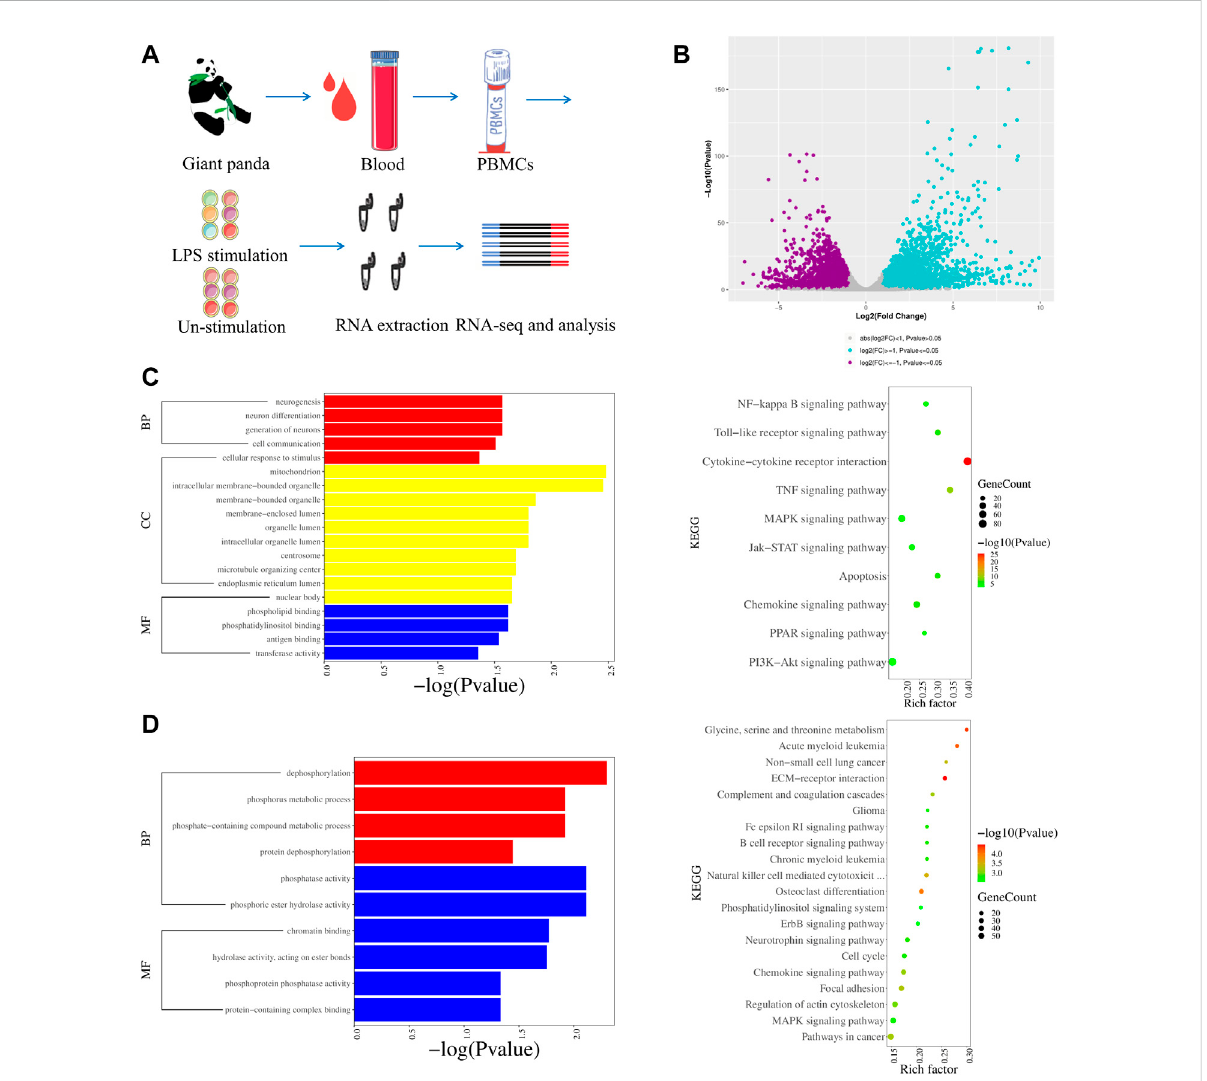
FIGURE 2 Transcriptomic pro fi les of LPS-stimulated and LPS-unstimulated PBMCs from giant pandas by RNA-seq. (A) Flow diagram of the experimental design. (B) VolcanoplotshowstheDEGsbycomparingtheLPS-stimulatedPBMCsandLPS-unstimulatedPBMCsfromgiantpandasatthetimepoint of6 h.Signi fi cantly differentiallyexpressedgeneswerede fi nedbyboth p -value(lessthanandequalto0.05)andfoldchange(greaterthanandequal to 2). (C) GO and KEGG enrichments of upregulated DEGs for the group of LPS-stimulated PBMCs vs. LPS-unstimulated PBMCs from giant pandas by RNA-seq. (D) GO and KEGG enrichments of downregulated DEGs for the group of LPS-stimulated PBMCs vs. LPS-unstimulated PBMCs from giant pandas by